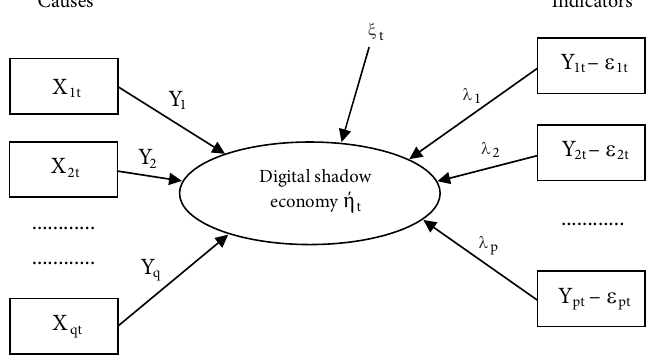
Figure 1. General structure of the MIMIC model